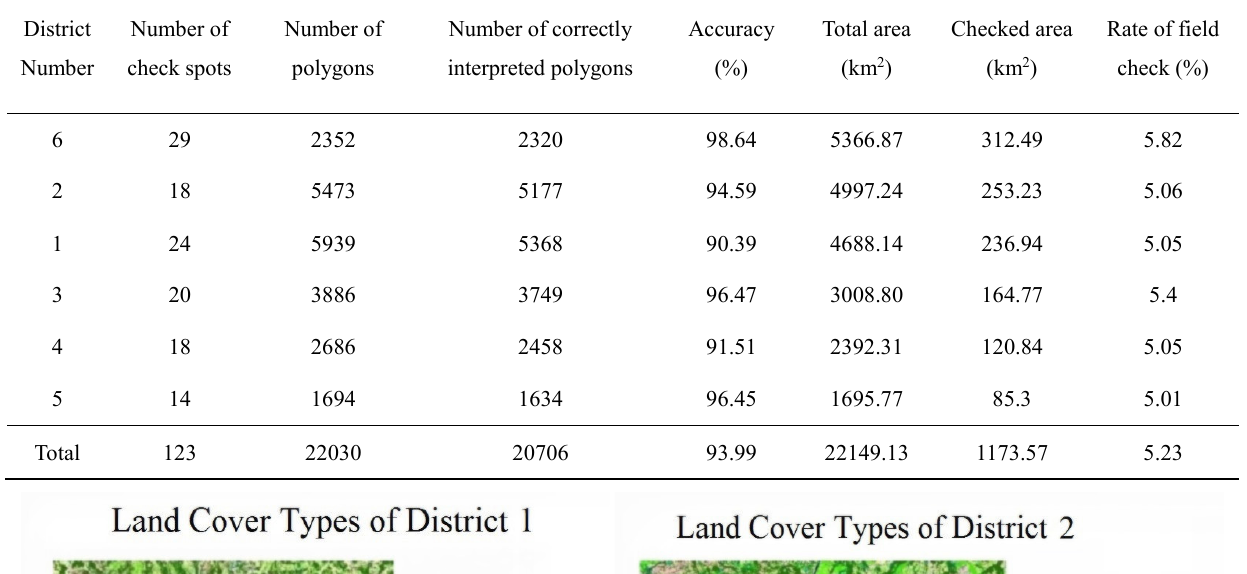
Table 2. Results of field check of researched counties and districts